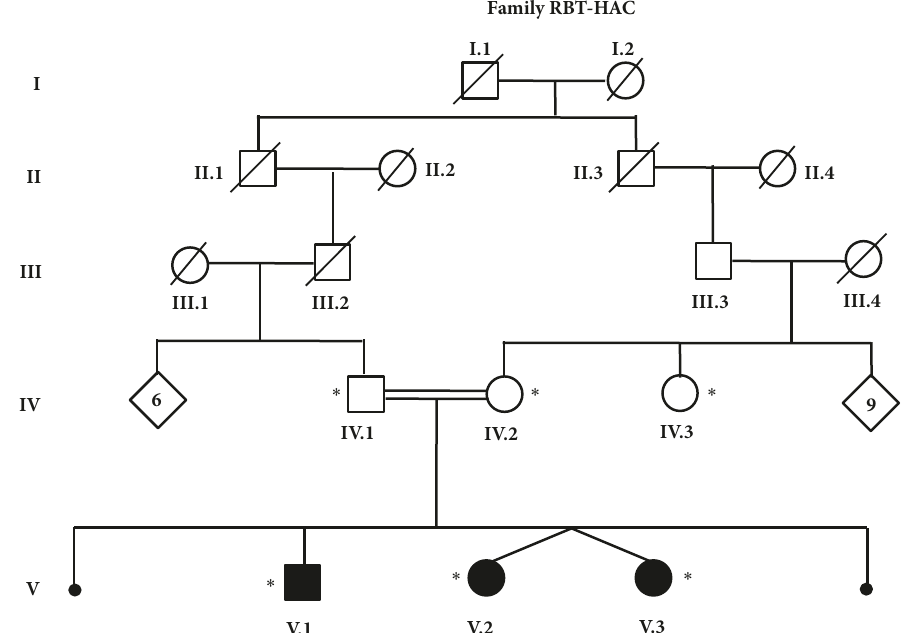
Figure 1: Pedigree of family RBT-HAC. Black and white symbols correspond to affected and asymptomatic members, respectively. Members who were included in the study were noticed with a